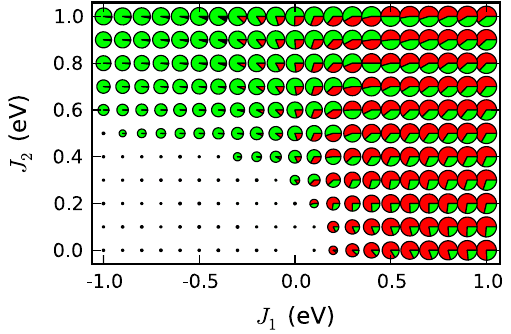
FIG. 10. The phase diagram of the two-pocket model. The Þ of the critical scale (cid:3) ;J and the competition variation with ð J c 1 2 between the s and d waves are depicted by the array of pie charts. In each pie, the two sectors denote the two leading pairing -wave pairing in green and the d -wave channels (the s x 2 y 2 x 2 (cid:1) y 2 pairing in red), with the angle of each sector proportional to pairing strength. The size of each pie reflects the critical scale ð (cid:3) = 10 (cid:1) 8 eV Þ(cid:3) 2 . , with its radius proportional to ½ log (cid:3) c c 10